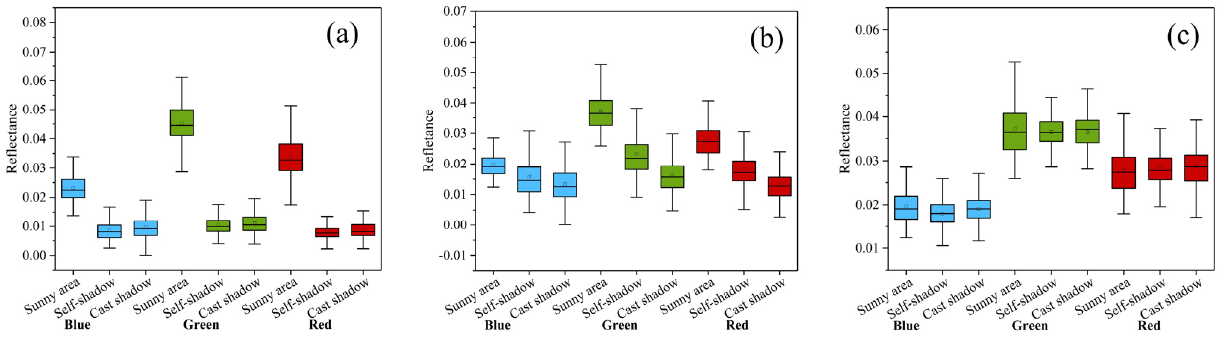
Figure 4. Box plot of the corrected red–green–blue (RGB) waveband reflectance: ( a ) ρ , ( b ) SCS + C, and ( c ) +S.